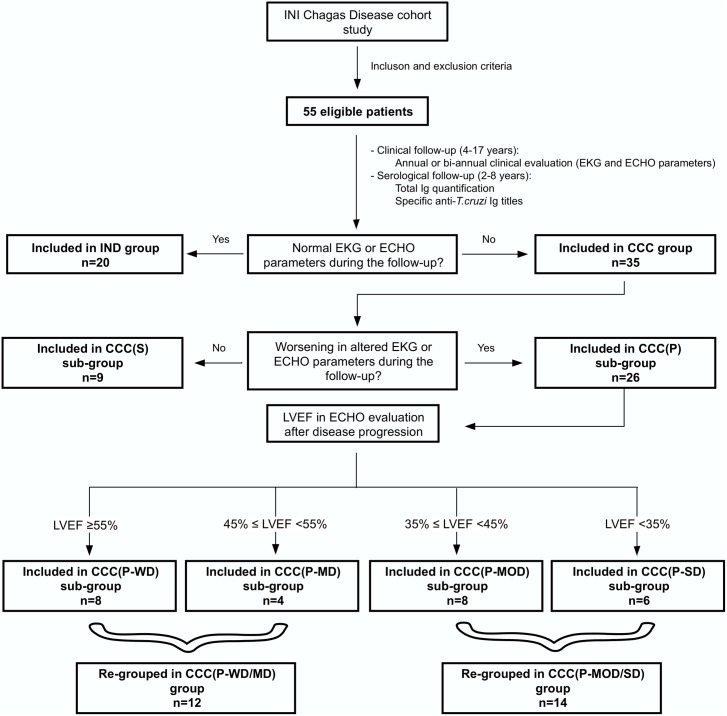
Study flowchart.Strategy used to define groups and sub-groups in the study.